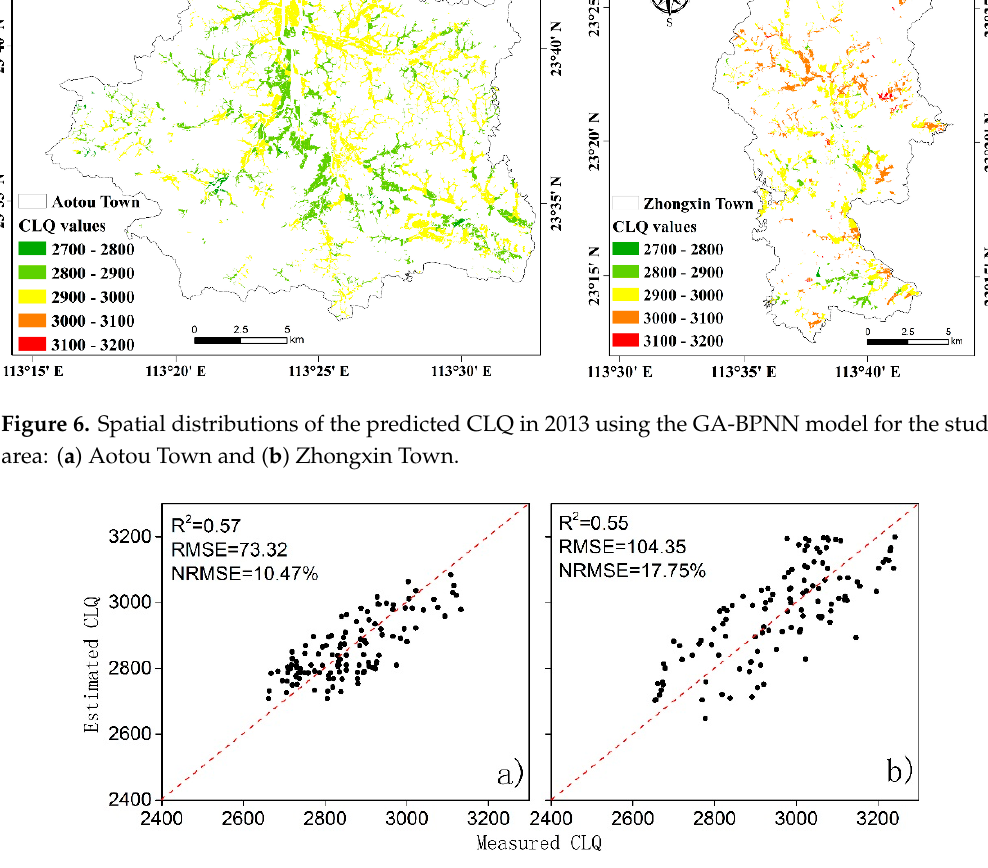
Figure 7. Measured and estimated CLQ in 2013 using the GA-BPNN model with the 120 validation sample plots for mapping: ( a ) Aotou Town and ( b ) Zhongxin Town.